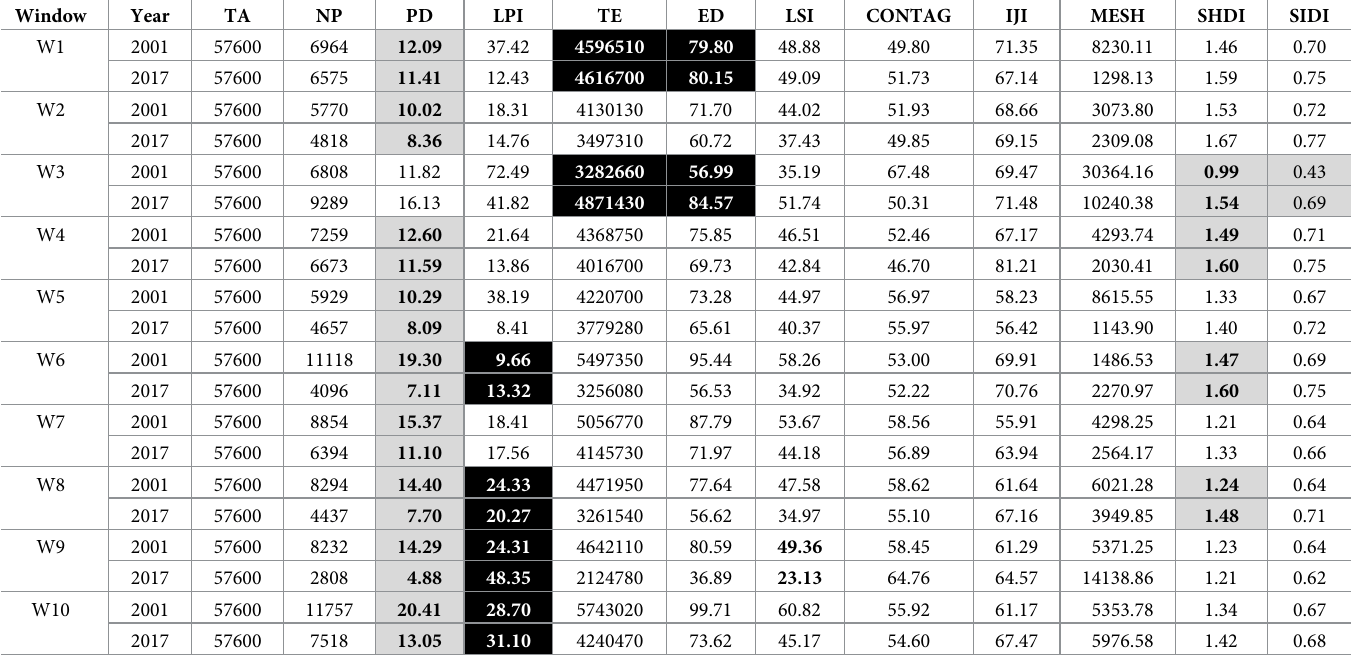
Table 4. Landscape-level metrics for the ten subsections (W1-W10) during 2001–2017.